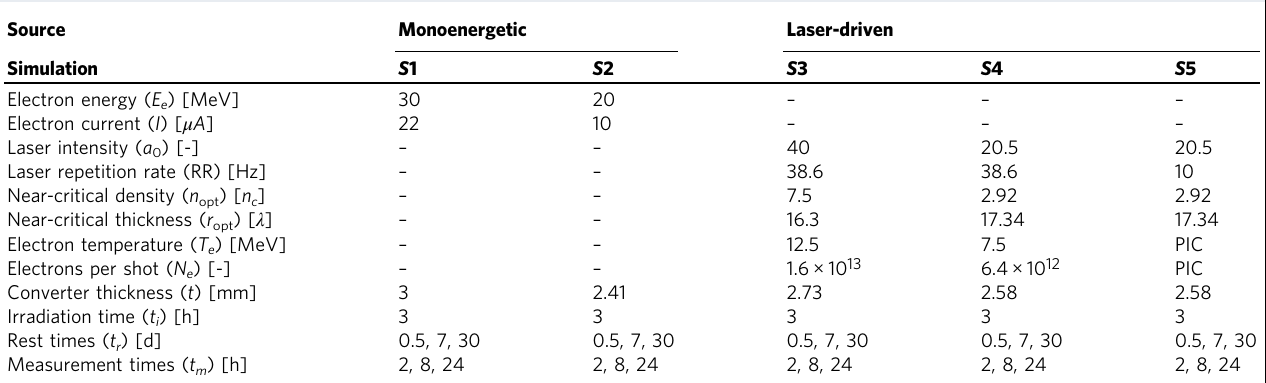
Table 1 Summary of the parameters adopted in the simulations. PIC stands for particle-in-cell.